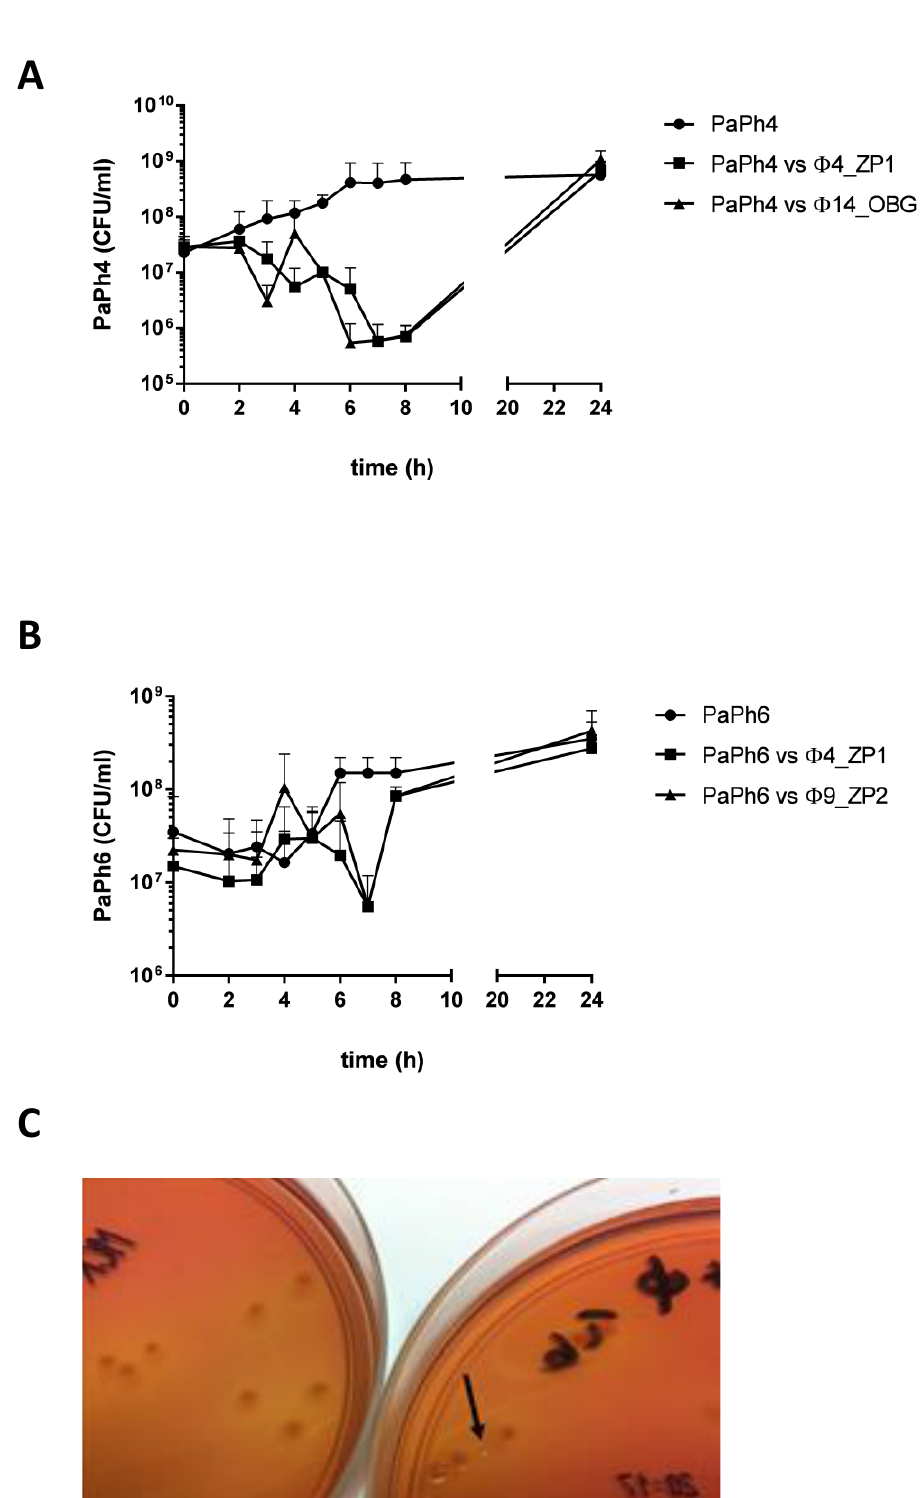
Figure 7. Phage in vitro activity against planktonic Pseudomonas aeruginosa (PA) cells. ( A ), the Pa_Ph4 isolate exposed to phages Φ 4_ZP1 and Φ 14_OBG at MOI 10. As control, Pa_Ph4 grown in medium alone. ( B ), the Pa_Ph6 isolate exposed to phages Φ 4_ZP1 and Φ 9_ZP2 at MOI 10. As control, Pa_Ph6 grown in medium alone. ( C ), the “small round” PA morphotype observed on MacConkey agar plates after exposing Pa_Ph4 to the phage Φ 4_ZP1 for 6 h (arrow on the right plate). Pa_Ph4 after 6-h culture without the phage (on the left plate).